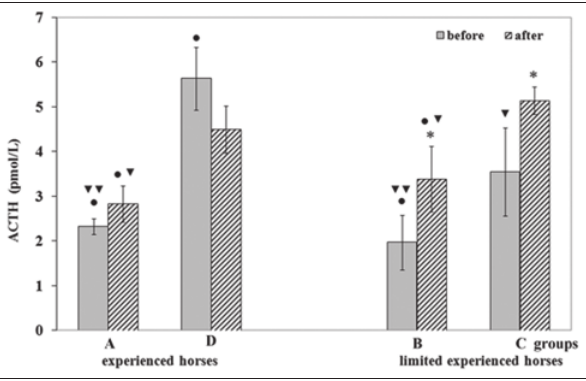
Figure-1: Circulating cortisol concentrations (mean ± standard deviation) of horses before and after road transport. Label x: Asterisk indicates significant (*p<0.001) differences versus before. Symbols indicate significant ( ● p<0.001) differences versus Group C and ( ▼ p<0.01; ▼▼ p<0.001) versus Group